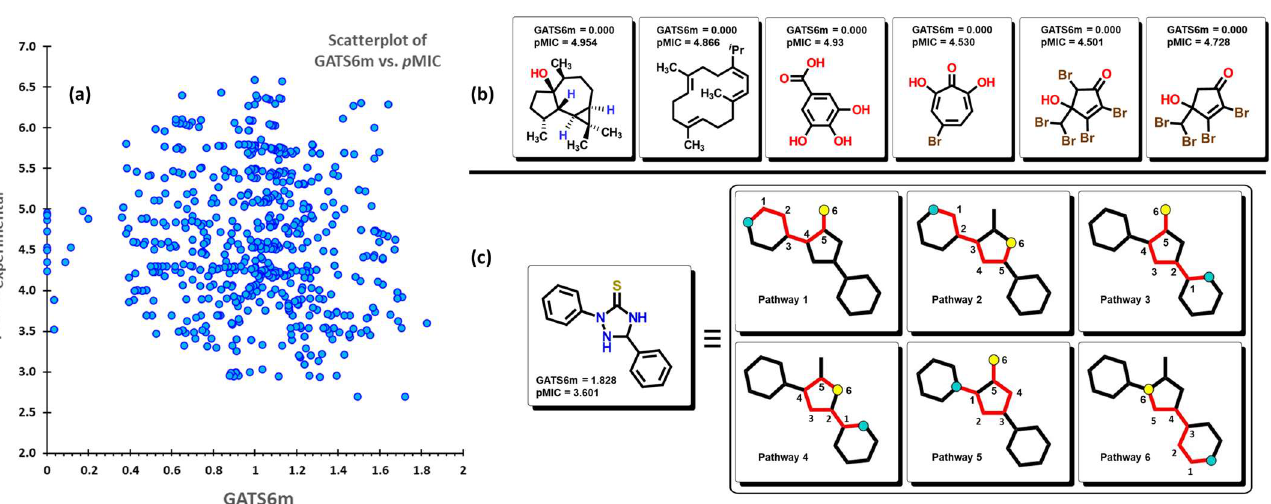
of aliphatic primary amides, the number of aliphatic ethers, and the number of imidazole moieties, respectively (Figure 9).